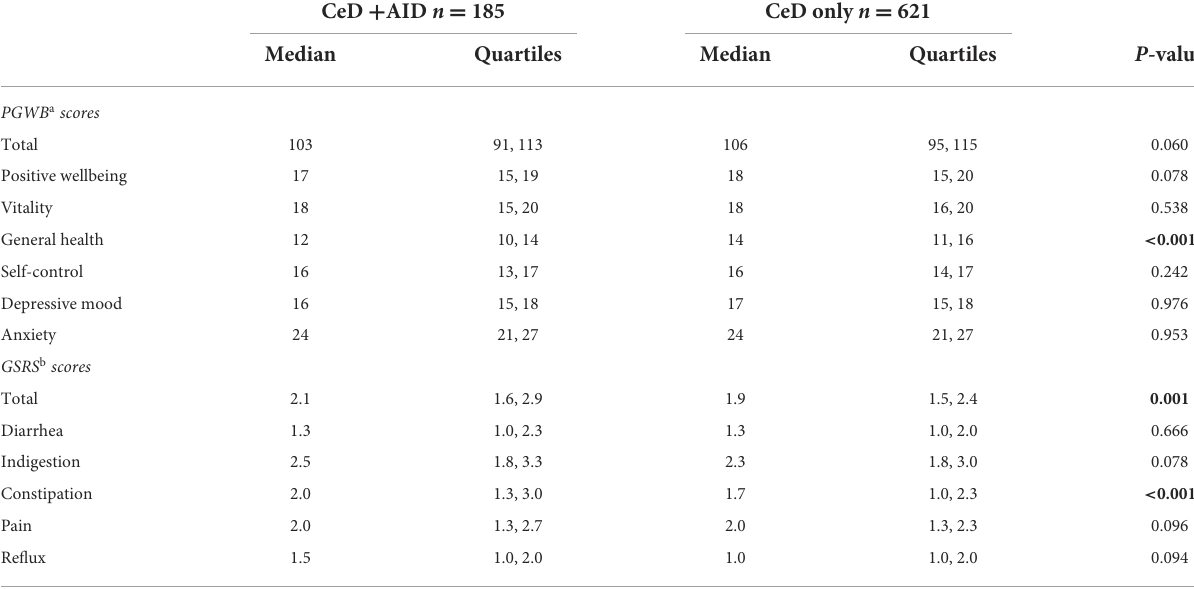
TABLE 3 Psychological General Well-being (PGWB) and Gastrointestinal Symptom Rating Scale (GSRS) scores of GFD treated celiac disease (CeD) patients with or without coexisting autoimmune disease (AID). CeD + AID n =